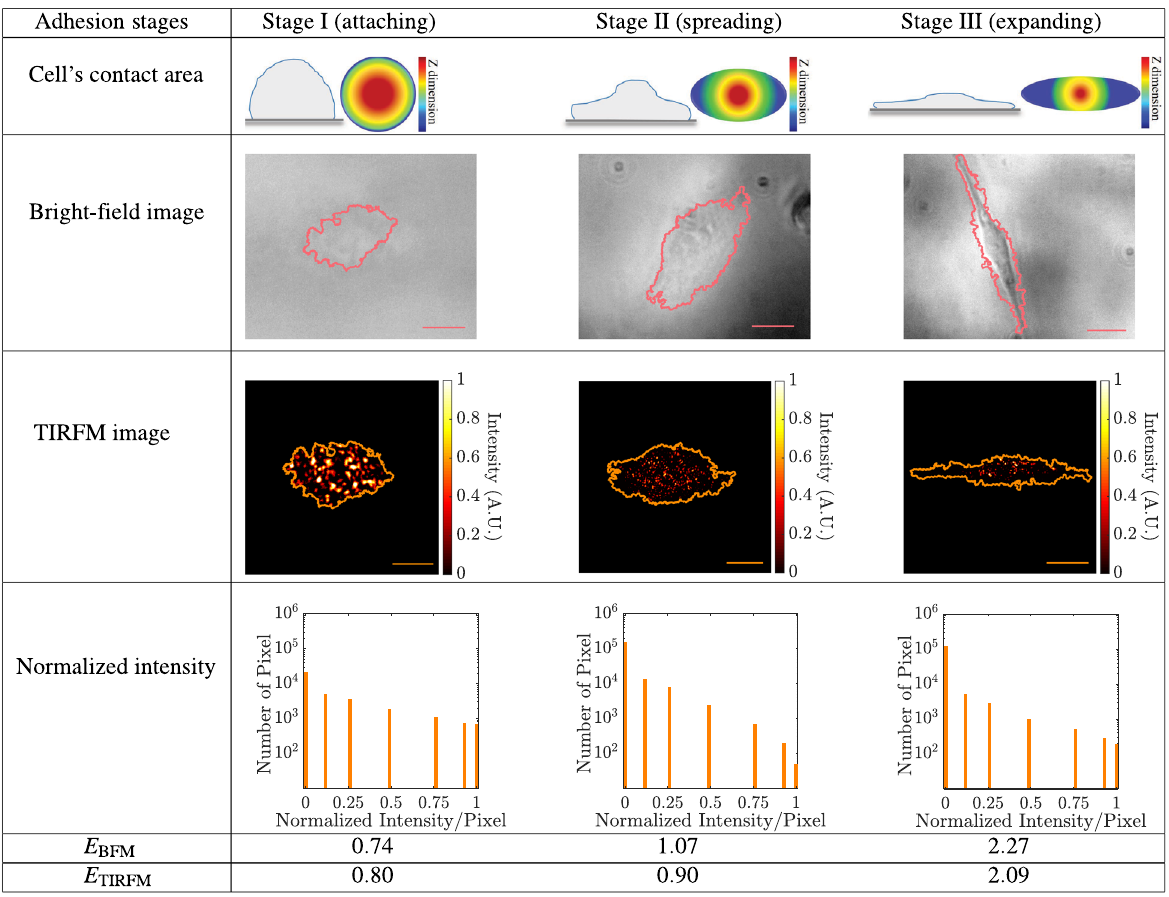
Table 1. Schematic diagrams of the cell’s contact-area, bright-field images, TIRFM-images of F-actin patches, and histogram of the normalized intensity (per pixel) of three melanoma cells (A-375), which are at three different adhesion stages. E BFM and E TIRFM are the elongation parameters corresponding to the cell shape and distribution of F-actin patches of the top-images, respectively. The scale bar is 5 µ m.